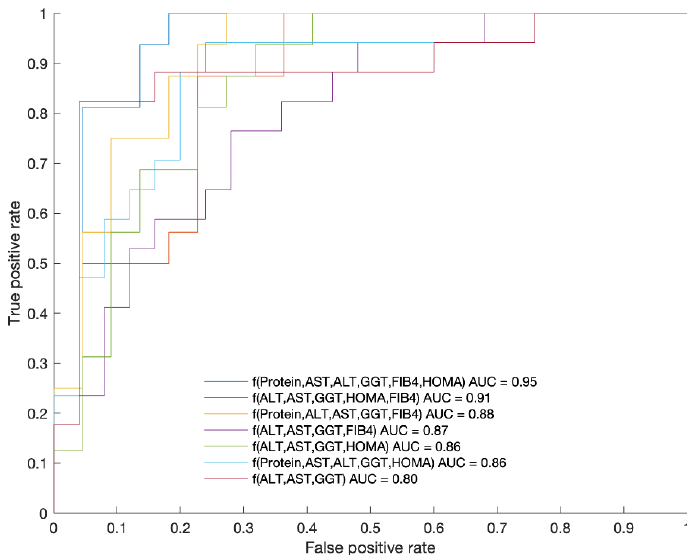
Figure 3. ROC curves of each of the presented functions as a combination of variables displaying the AUC values. The corresponding ROC metrics (sensitivity and specificity) are as follows: f(Protein, AST, ALT, GGT, FIB-4, HOMA-IR) (0.81,0.95), f(AL, AST, GGT, HOMA-IR, FIB-4) (1.00,0.73), f(Protein, ALT, AST, GGT, FIB-4) (0.82,0.96), f(ALT, AST, GGT, FIB-4) (0.88,0.80), f(ALT, AST, GGT, HOMA-IR) (0.88,0.77), f(Protein, AST, ALT, GGT, HOMA-IR) (0.69,0.86), f(ALT, AST, GGT) (0.53,0.88). The best function obtained for splitting both groups with AUC = 0.95 was: f = 27.444 + ( − 2.9636 × [protein]) + 0.25195 × [AST] + ( − 0.36118 × [ALT]) + 0.014958 × [GGT] + ( − 3.6456 × [FIB-4]) + ( − 0.057339 × [HOMA-IR]). The p value of this function was 0.000043 with a threshold to split both cohorts of 1.37.